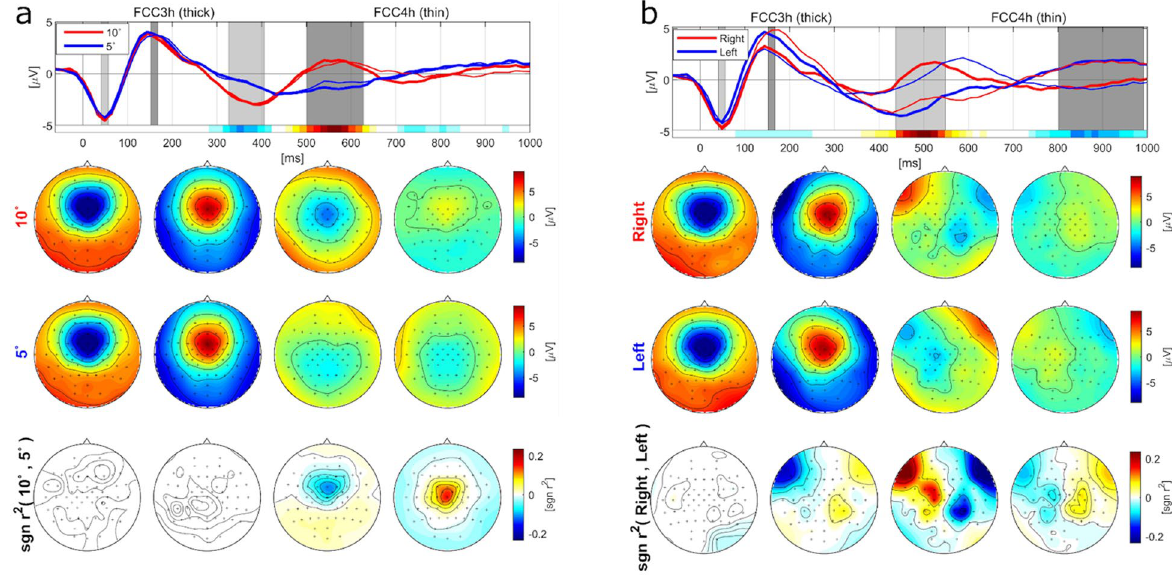
Figure 4. Grand average PEPs over all the participants on the offline data, time-locked to the perturbation onset obtained from the accelerometer. The first row shows the grand average EEG plots for FCC3h and FCC4h in thick and thin lines, respectively. The second and third rows represent the scalp for each condition, and the last row indicates the signed r2 between two classes. The scalp topographies refer to the shadowed areas in the first row plot. ( a ) Grand average potentials and scalp plots are depicted for 10 (red) and 5 (blue) degree perturbations. ( b ) Grand average potentials and scalp plots are represented for right (red) and left (blue)